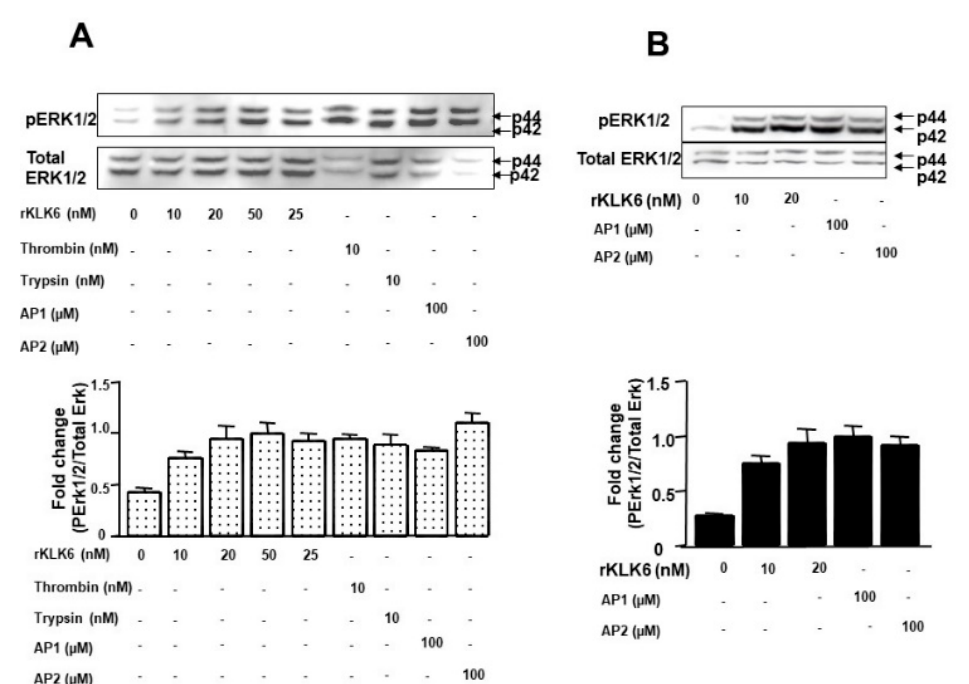
Figure 4. Dose-dependent activation of p42/p44 MAP-Kinase phosphorylation by KLK6. ( A ) Quies- cent HT-29 cells were stimulated with the indicated concentrations of KLK6, thrombin (0.01 µ mol/L), trypsin (0.01 µ mol/L), with 100 µ M of TFLLR-NH 2 (AP1, a PAR1 agonist), 100 µ M SLIGKV-NH 2 (AP2, a PAR2 agonist) or with vehicle (control) for 5 min. ( B ) Quiescent HCT116 cells were stimulated with the indicated concentrations of KLK6, with 100 µ M of TFLLR-NH 2 (AP1, a PAR1 agonist), with 100 µ M SLIGKV-NH 2 (AP2, a PAR2 agonist) or with vehicle (control) for 5 min. To confirm equal protein loading, the membranes were stripped and incubated with p42/p44 MAP-Kinase antibody. p42/p44 MAPKinase protein seems to be reduced in PARs agonist-stimulated samples, possibly be- cause the high signal with the anti-phopsho-ERK1/2 (Thr202/Tyr204) antibody prevents subsequent anti-ERK1/2 antibody binding to the ERK1/2 epitope as observed previously [9]. Densitometric analysis of the phospo-p42/p44 MAP-Kinase divided by total amount of p42/p44 MAP-Kinase is represented in lower panels. Results are representative of two separate